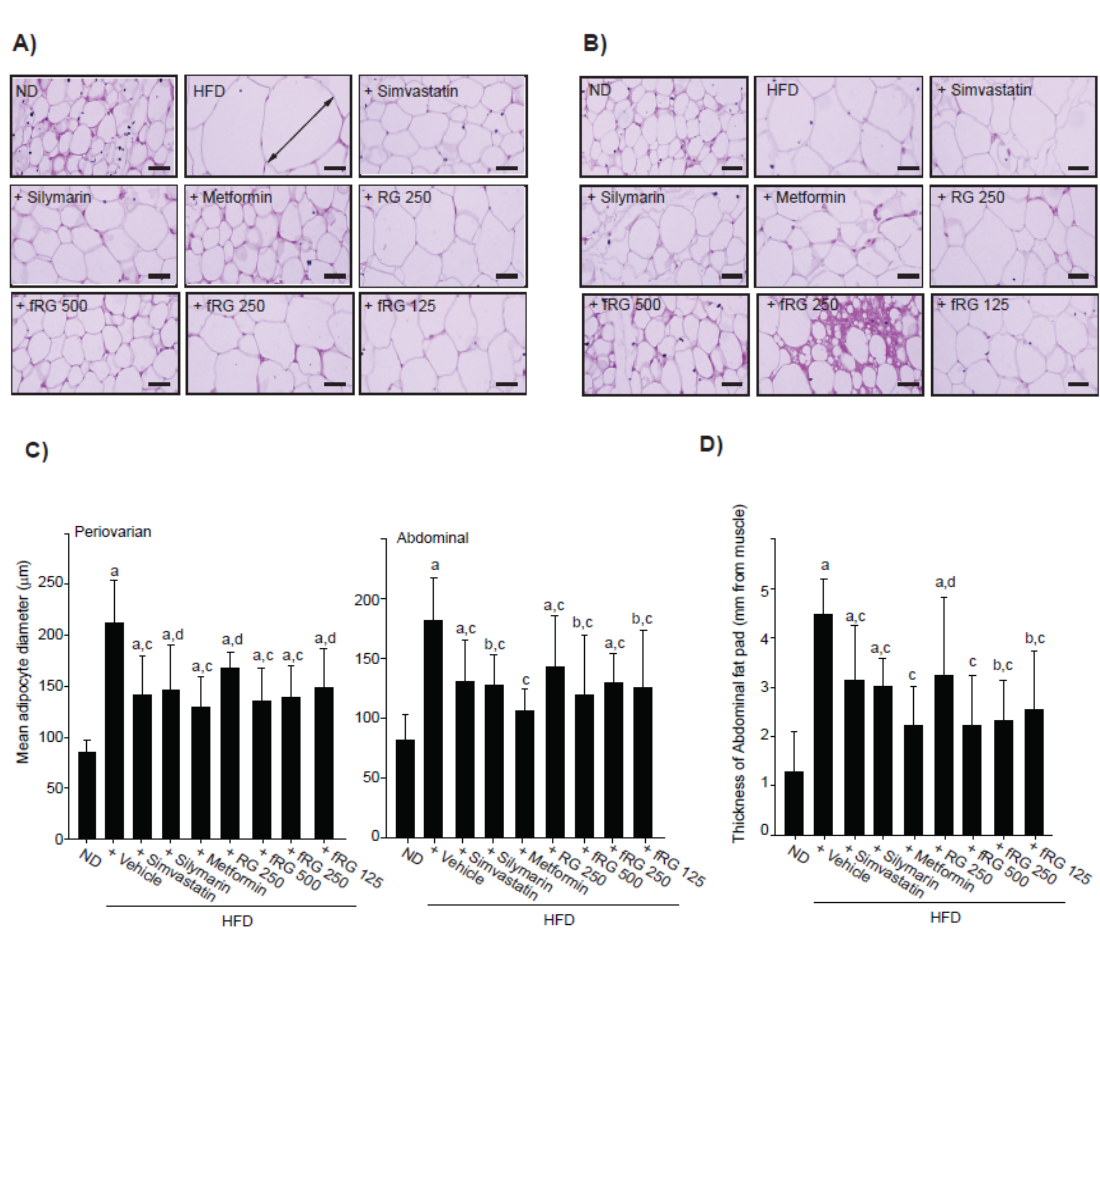
Figure 2. Histomorphometrical changes of the fat pad in fRG-treated mice. The representative histological images of fat from periovarian ( A ) or abdominal ( B ) tissues were stained with H & E. The arrow indicates the diameter of adipocytes measured (Scale bars = 80 μ m). The mean diameter of at least 10 periovarian or abdominal white adipocytes ( C ), and the thickness of the fat pads in abdominal cavity ( D ) were measured using automated image analysis process. All values were expressed mean ± S.D. of eight mice (Significant as compared with ND-fed mice, a p < 0.01; b p < 0.05; significant as compared with HFD-fed mice, c p < 0.01; d p <